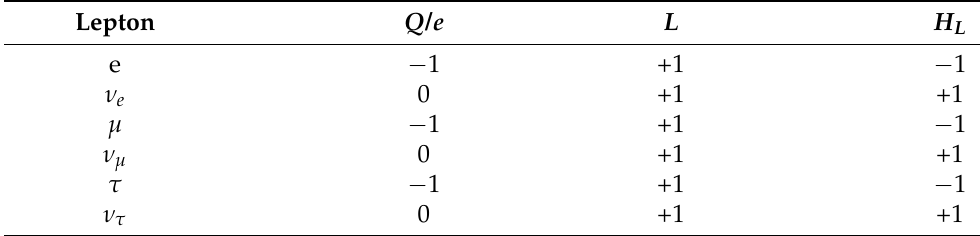
Table 2. Additive quantum numbers of leptons. Antileptons have additive quantum numbers with the same absolute values as leptons but opposite sign of